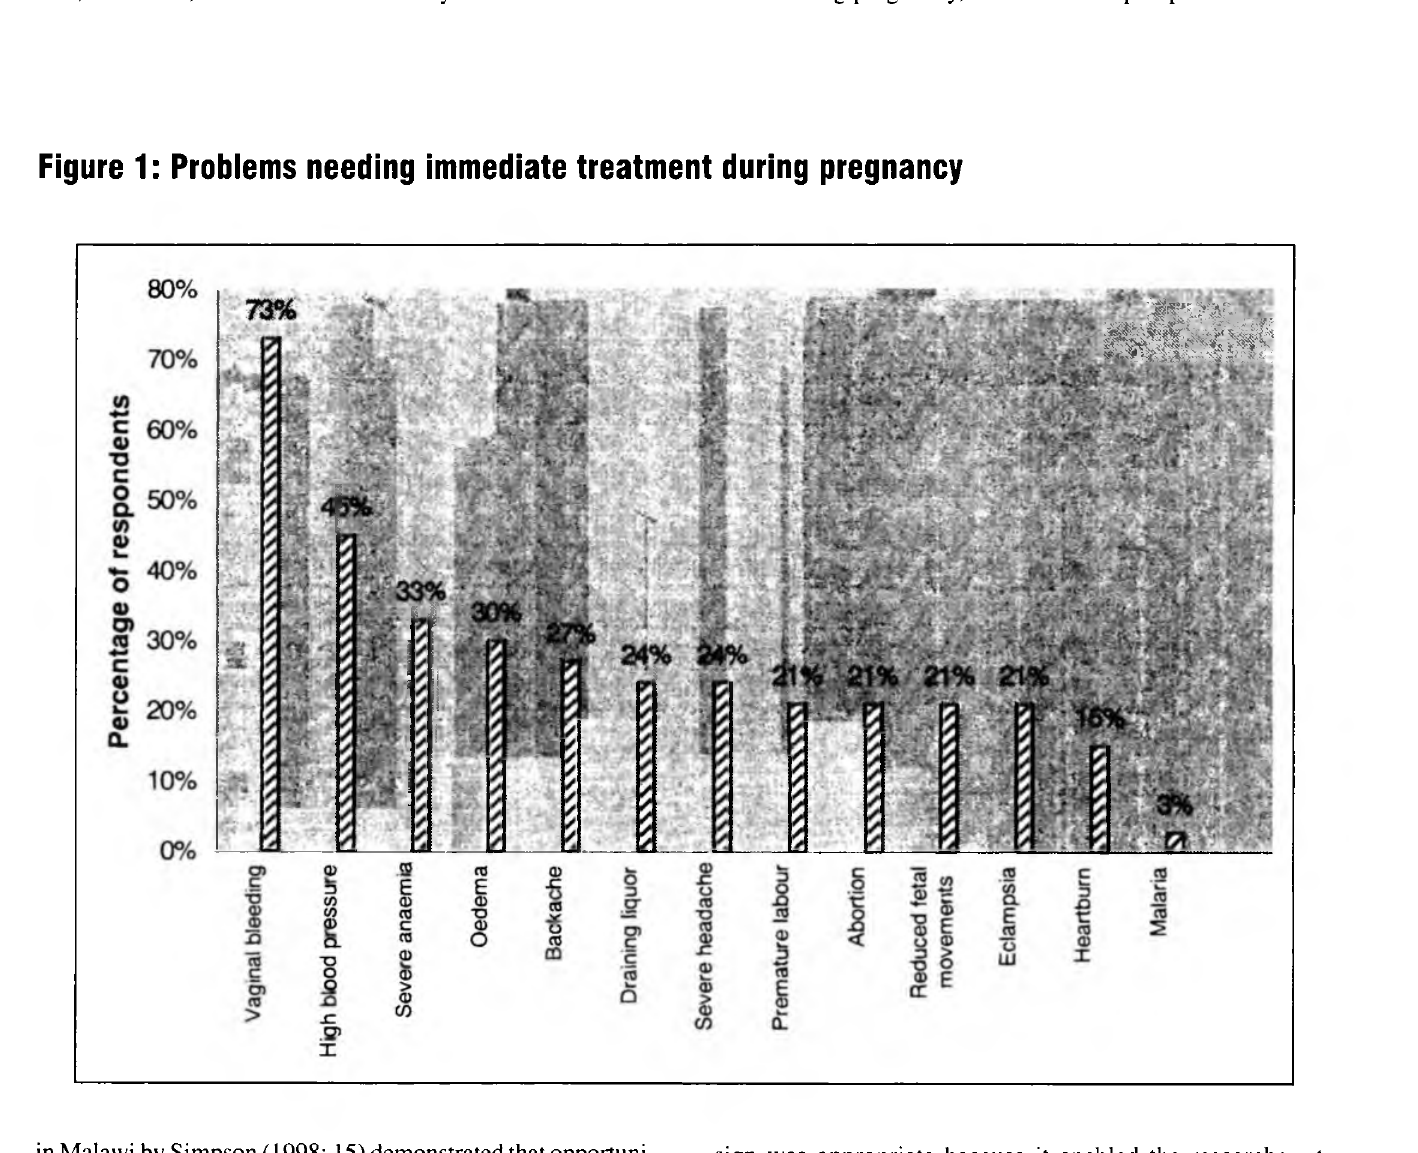
Figure 1 : Problems needing immediate treatment during